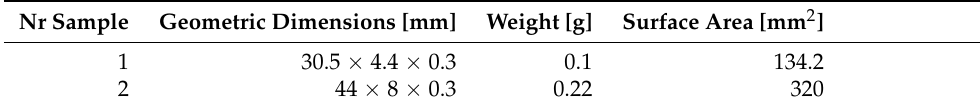
Figure 2. The region of the tested electroactive polymer IPMC based on Nafion/Pt under the Keyence Digital Microscope was examined. The analysis of the mass spectra of the IPMC has provided and has localized the spatial distribution of specific molecules and compositional in % of carbon, silicon powders, oxygen, platinum and fluorine (1 µ m) ( a ) and Surface morphology of IPMC material (20 µ m) ( b ). Table 1. Geometrical properties of polymer–metal